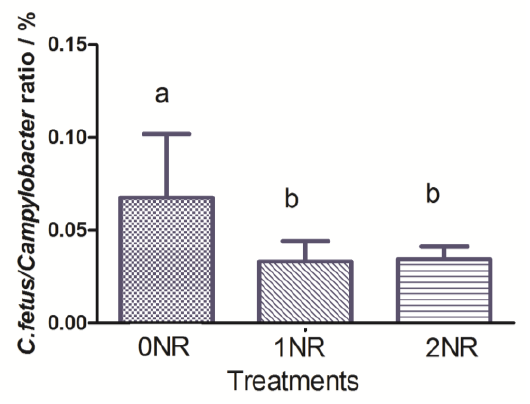
Figure 2. C. fetus to C ampylobacter ratio of different